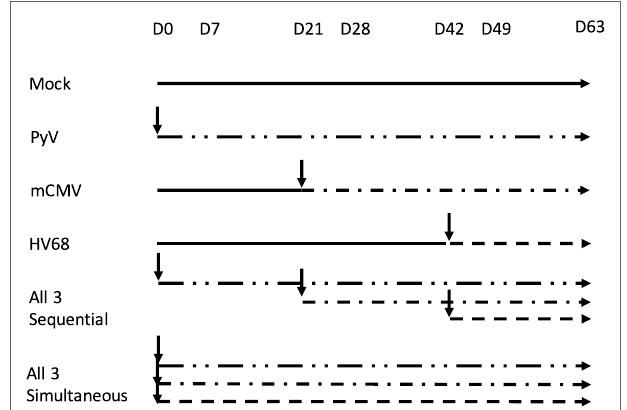
FigUre 1 | Experimental design for sequential and simultaneous viral infections of C57BL/6 mice. Mice that received single or sequential polyomavirus (PyV) infection were injected on day 0, all other groups received sterile PBS injections. Mice that received single or sequential murine cytomegalovirus (mCMV) infection were injected on day 21; all other groups received sterile PBS injections. Mice that received single or sequential HV68 infection were injected on day 42, all other groups received sterile PBS injections. Mice that received simultaneous infections were injected with PyV, mCMV, and HV68 on day 0, mock-infected mice received sterile PBS